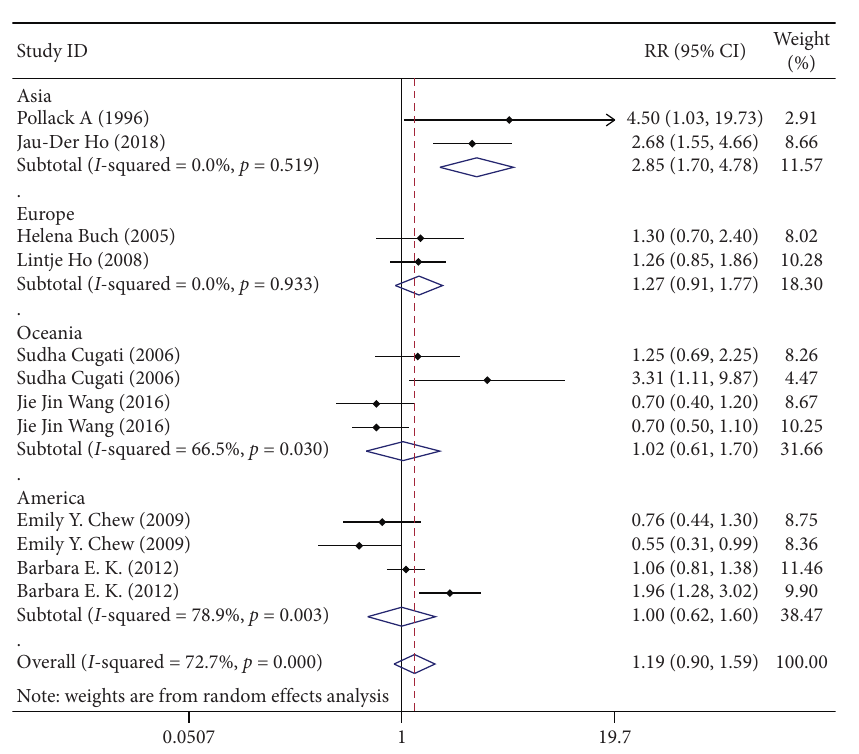
Figure 6: Subgroup analysis on different